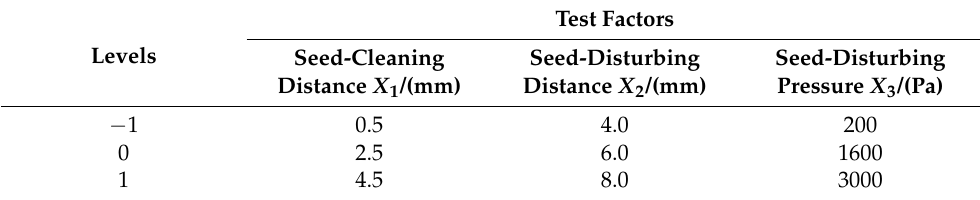
Table 1. Box–Behnken test factors and levels.